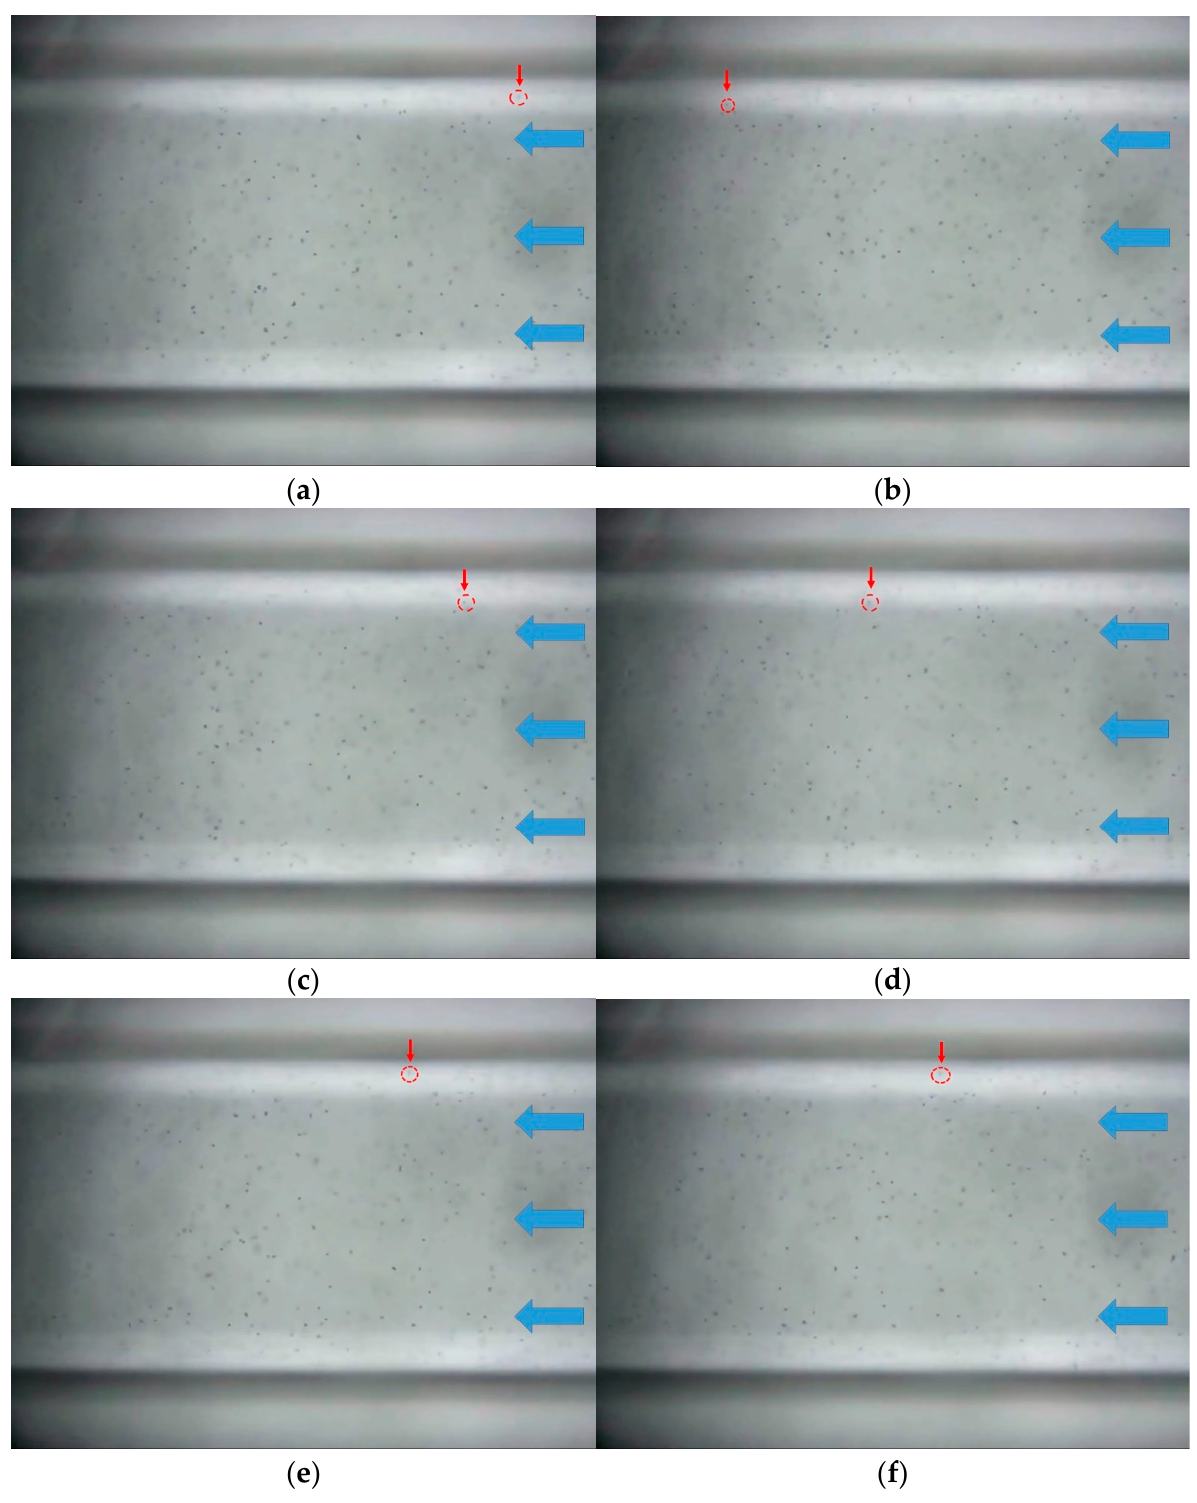
Figure 6. Experimental results of flow characteristics of copper contaminants–capillary tube side of center: ( a ) Particle position before moving 1; ( b ) particle position after moving 1; ( c ) particle position before moving 2; ( d ) particle position after moving 2; ( e ) particle position before moving 3; ( f ) particle position after moving 3.